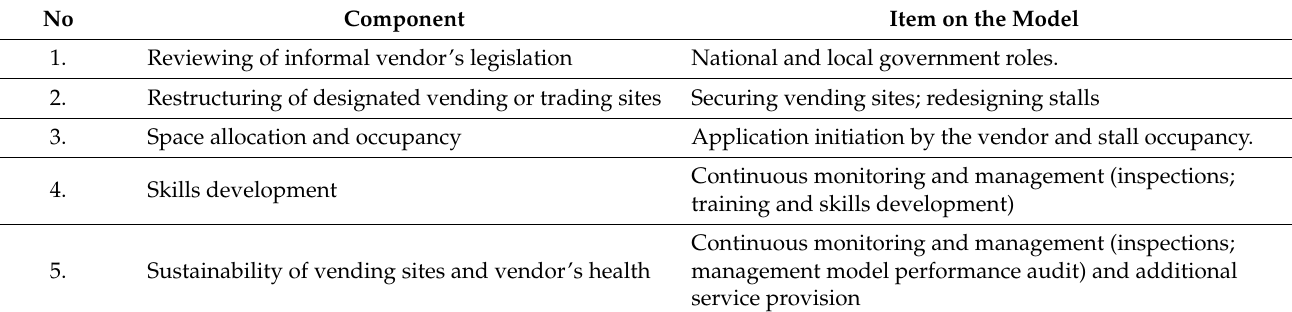
Table 1. Description of the components as per items listed on the informal vendors’ integrated management model.